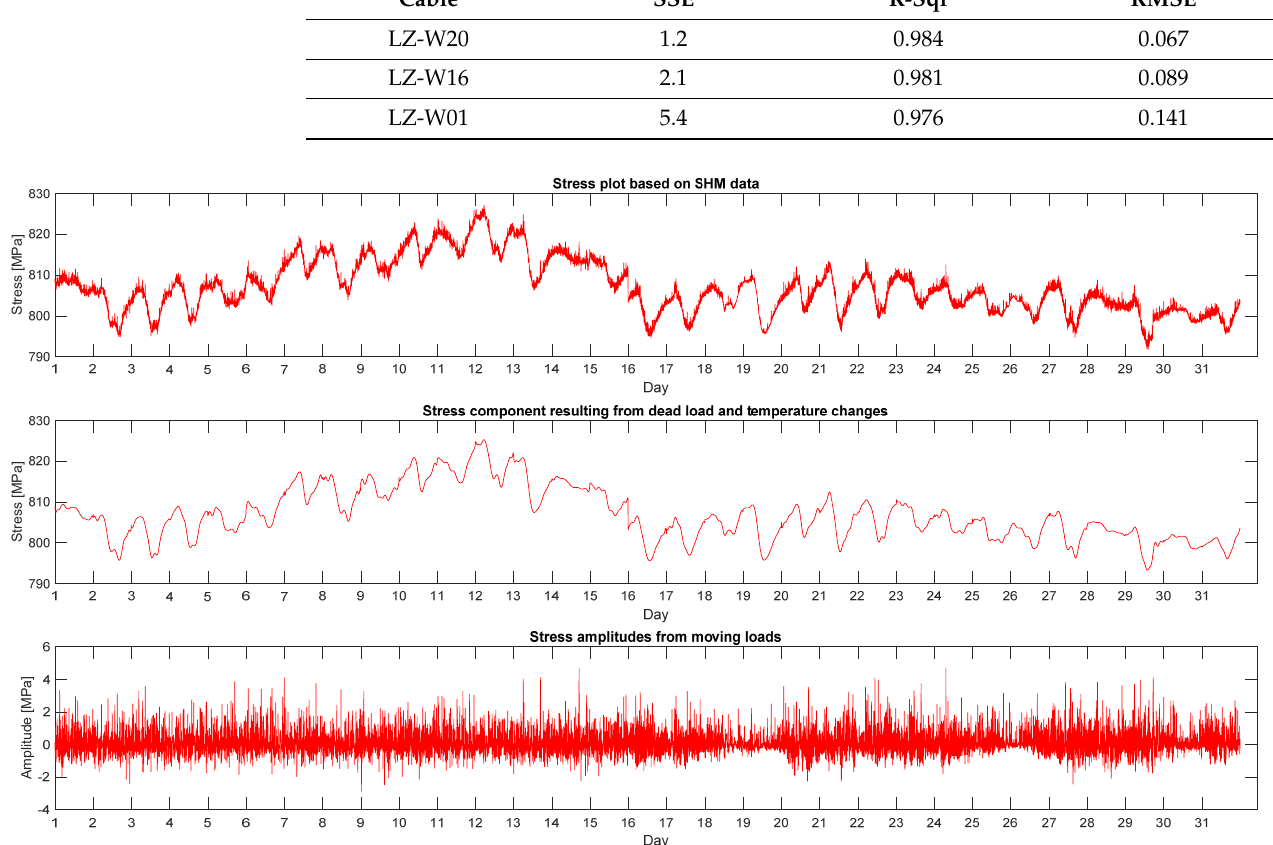
Figure 16. Graphs showing split data according to the described algorithm.